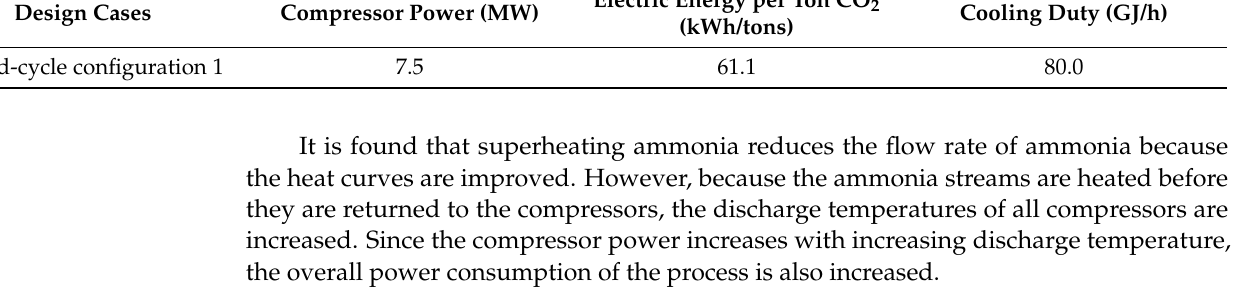
Table 7. Results for the closed-cycle configuration 1.